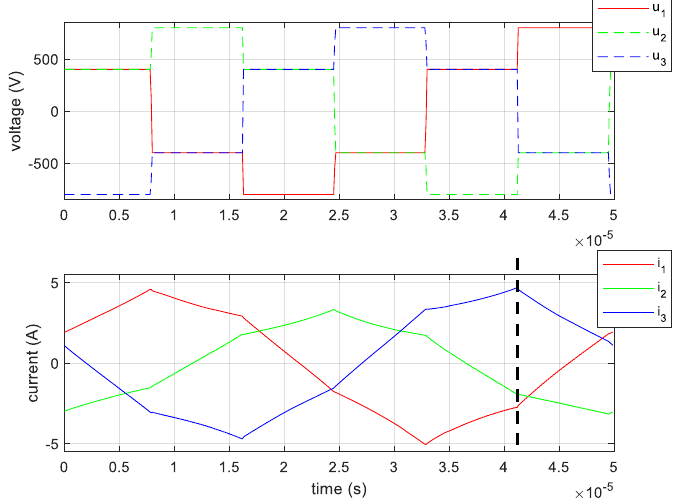
Figure 10. MFT no load test magnetic transient simulation result: primary phase voltage ( top ) and primary current ( bottom ); the dashed vertical line indicates the time instant for the magnetostatic simulation.